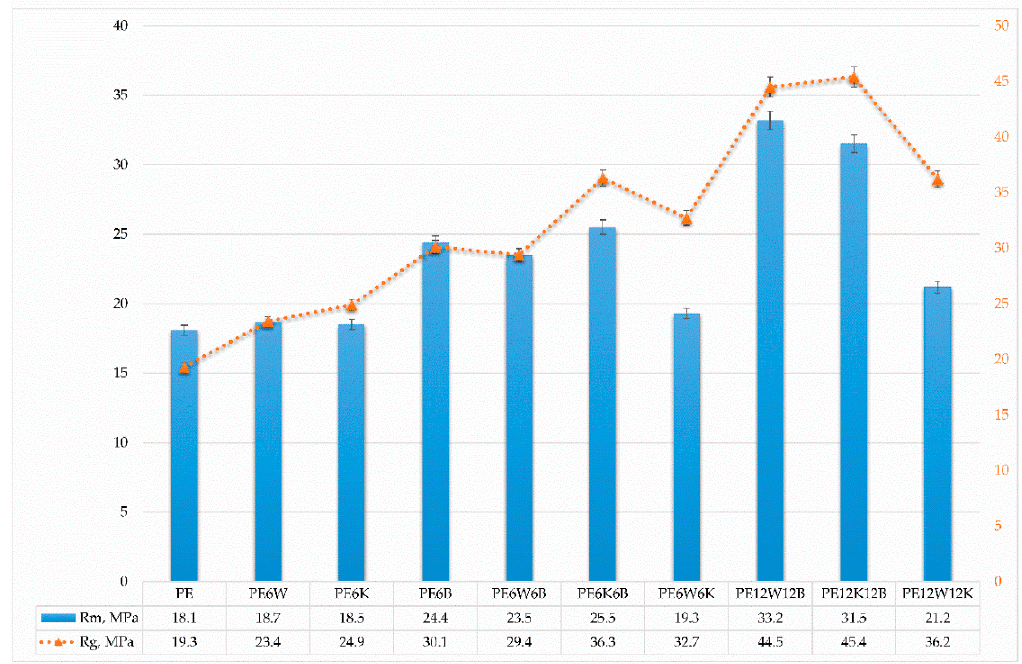
Figure 1. Comparison of tensile (Rm) and flexural (Rg) strength of tested materials.